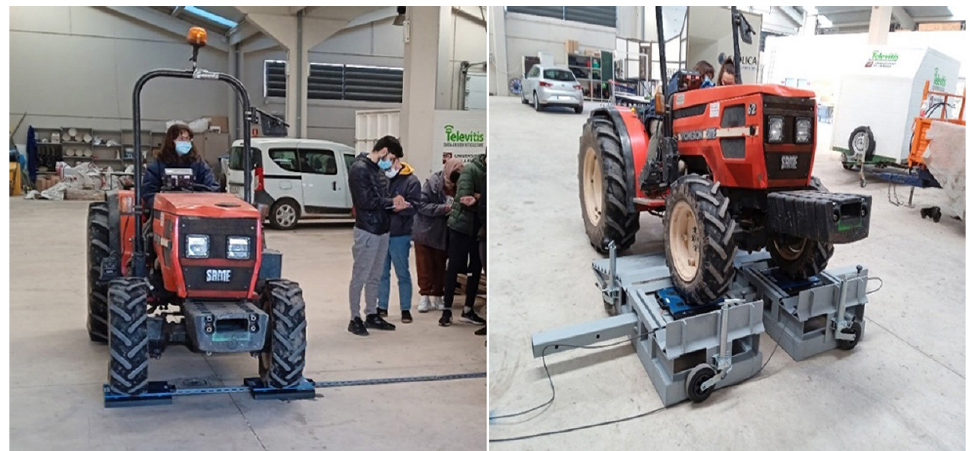
Fig. 3. Tractor weighing process: (left) the tractor on a flat surface to determine the center of gravity location between the two axles; (right) the tractor on the ramps to determine the height of the center of